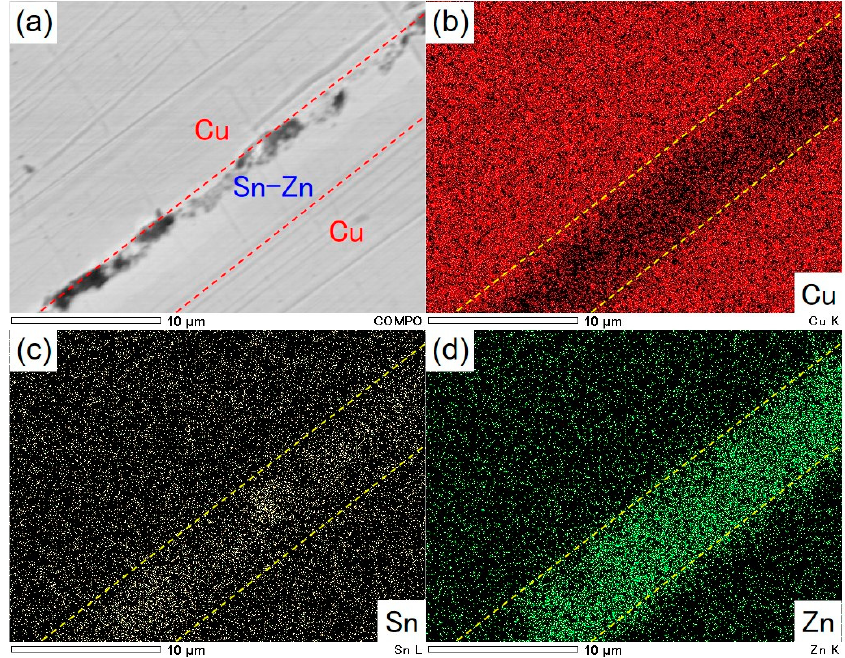
Figure 8. Cross-sectional SEM image of copper rods that were solder-jointed with an electrodeposited Sn-39 at.%Zn alloy film ( a ) EDX elemental mapping images of Cu, Sn and Zn are also shown in ( b ), ( c ) and ( d ), respectively.